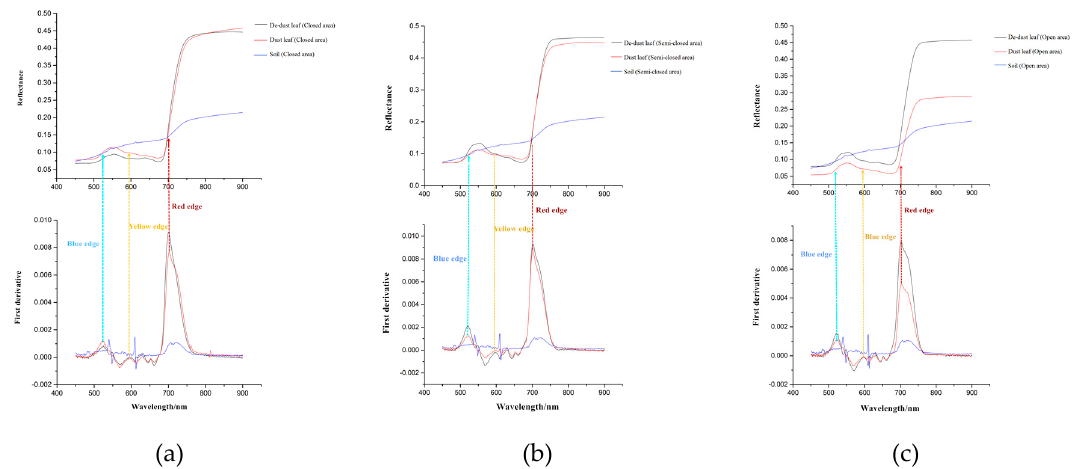
Figure 5. Spectral curves of leaves before and after cleaning by first derivative treatment: ( a ) closed area, ( b ) semi-closed area, and ( c ) open area.